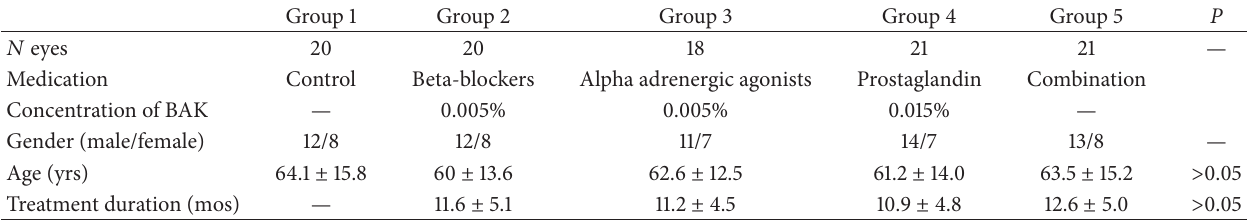
Table 1: Demographic features of control (group 1) and antiglaucoma therapy groups (groups 2, 3, 4, and 5).